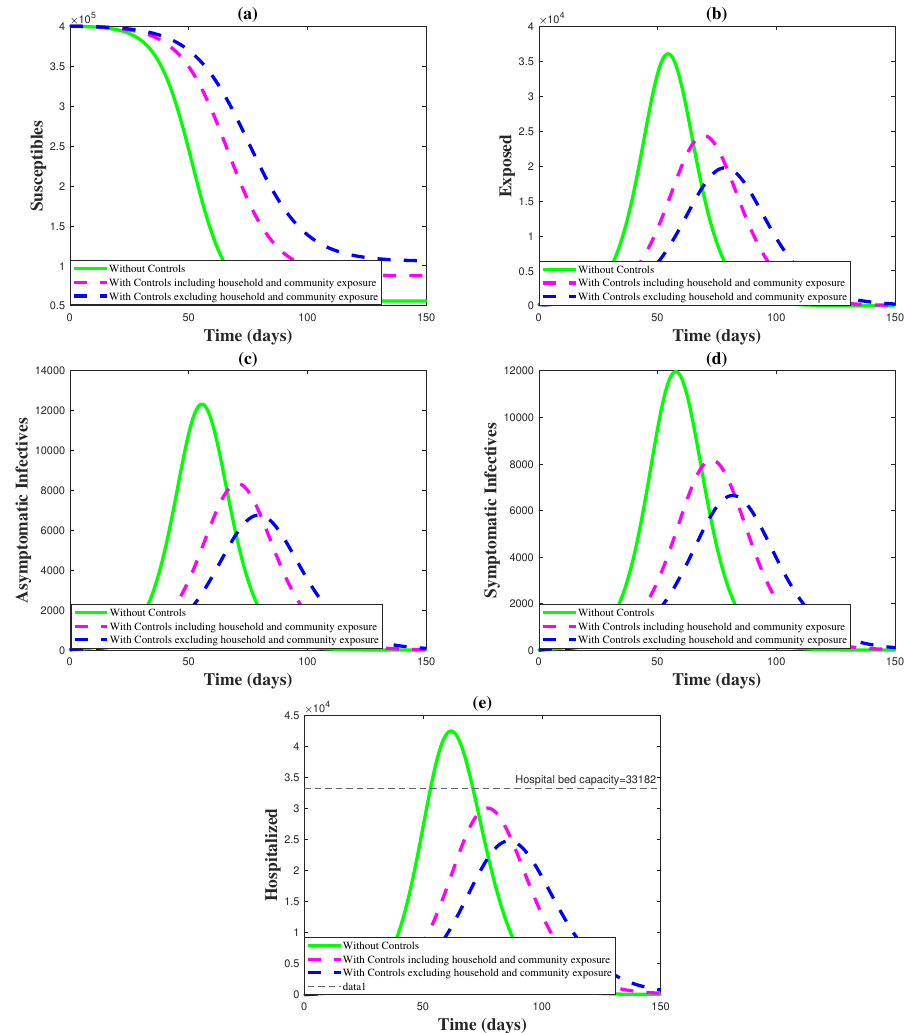
Fig. 11: A comparison of state variables with and without